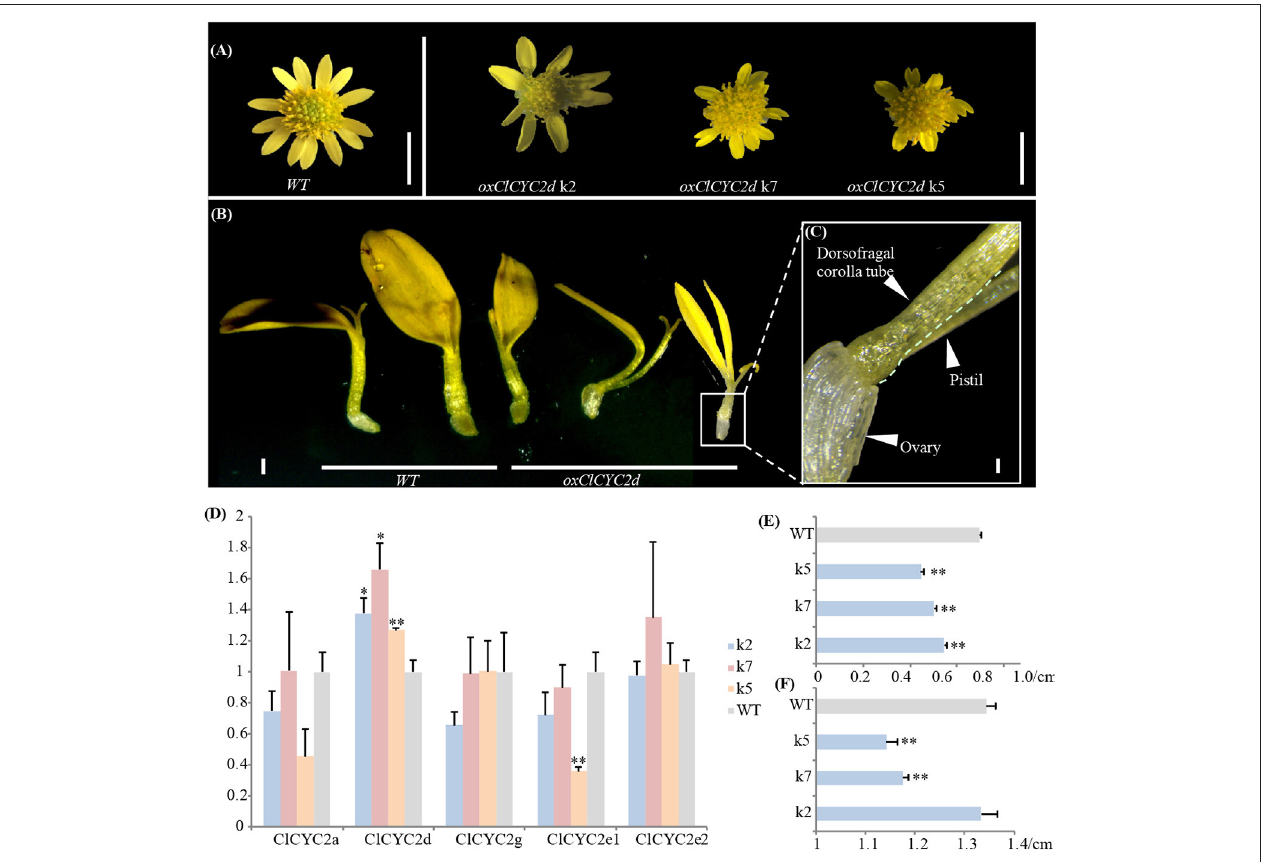
FIGURE 5 | Ectopic expression of ClCYC2d of Chrysanthemum lavandulifolium suppresses the growth of rays. (A–C) Capitulum and ray phenotypes of transgenic lines compared to wild-type plants. Bars 5mm (A) , 1mm (B) , and 0.1mm (C) . (D) Changes in expression of CYC2 -like genes between transgenic lines and the = wildtype. (E,F) Changes in lengths of ray flowers and diameters of capitula. Error bar is s.e. value of three biological samples. Statistical significance were tested ± using the two-tailed t -test: * P 0.05; ** P ≤ ≤